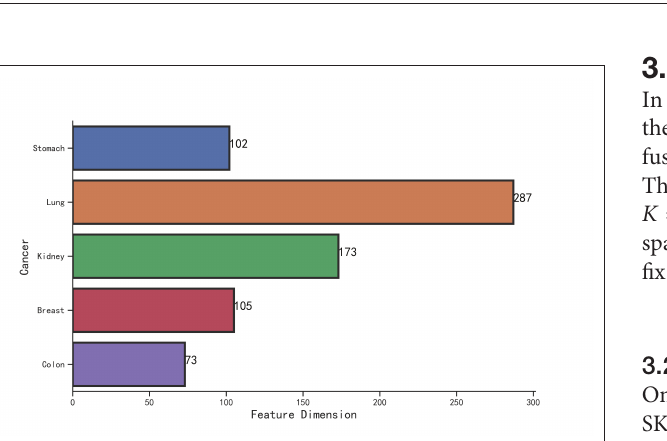
FIGURE 2 | Comparison between SKF and other fusion models.